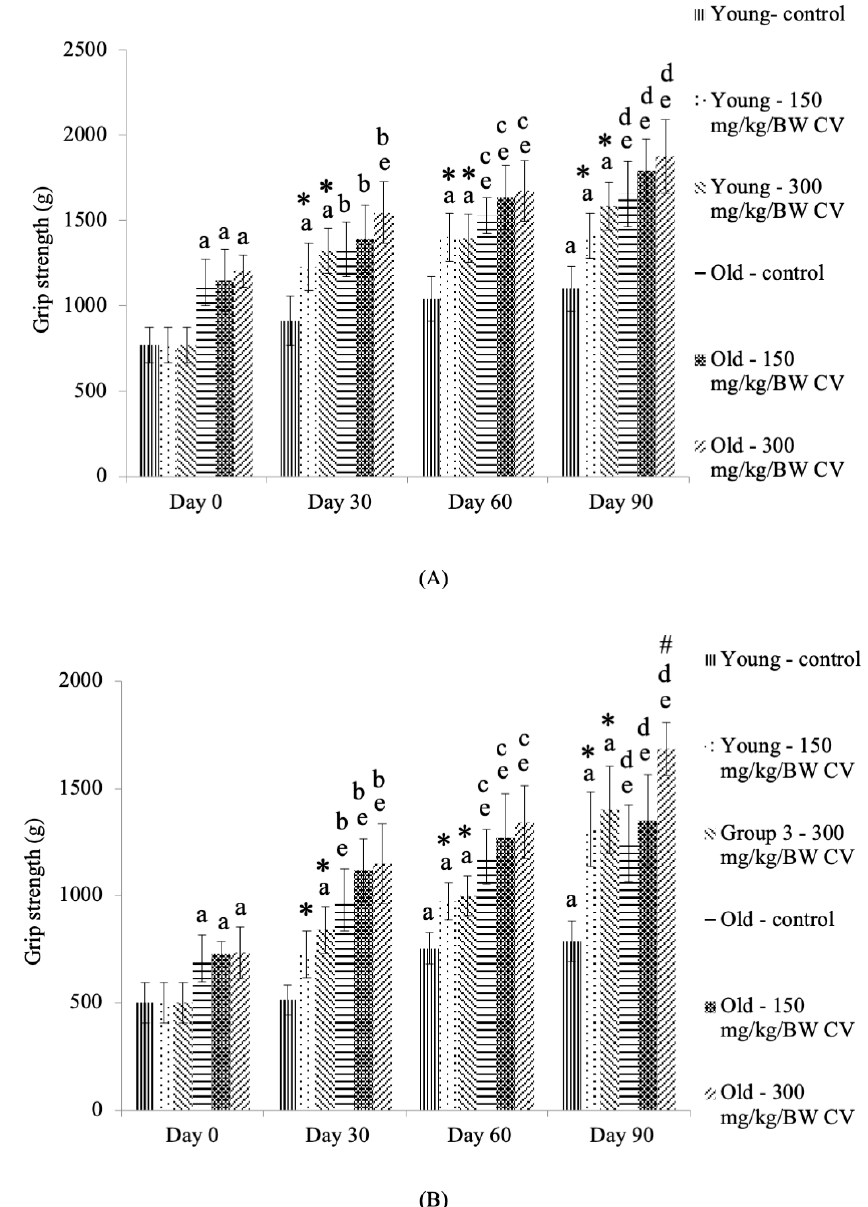
Figure 2. The grip strength of ( A ) the front paws and ( B ) the hind paws of young and old rats. The data are presented as the mean ± SD, n = 8 (control rats), n = 10 ( C. vulgaris -treated rats). * p < 0.05 significantly di ff erent compared to the control young rats on the respective day, # p < 0.05 significantly di ff erent compared to the control old rats on the respective day, a p < 0.05 significantly di ff erent compared to the control young rats on Day 0, b p < 0.05 significantly di ff erent compared to the control young rats on Day 30, c p < 0.05 significantly di ff erent compared to the control young rats on Day 60, d p < 0.05 significantly di ff erent compared to the control young rats on Day 90, e p < 0.05 significantly di ff erent compared to the control old rats on Day 0, with a post hoc Tukey HSD test. BW: Body weight; CV: C.